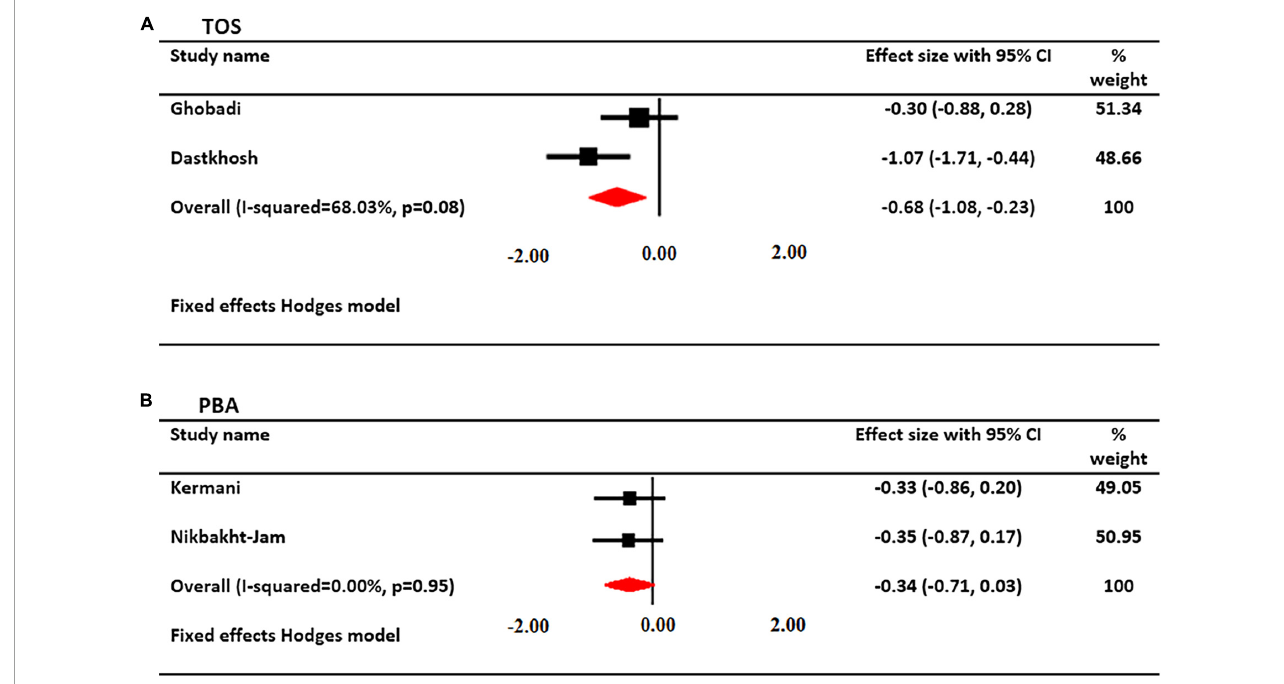
FIGURE5 Forest plot showing the summary effect size for (A) total oxidant status (TOS) and (B) pro-oxidant/antioxidant balance (PAB) levels between saffron and placebo groups.